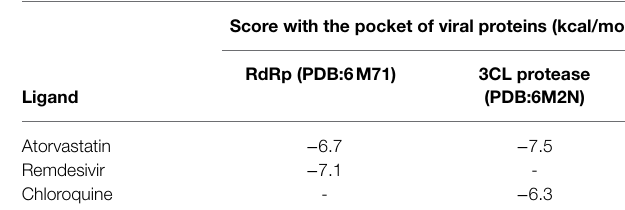
TABLE 3 | Molecular docking of atorvastatin and positive controls of interaction (Remdesivir and Chloroquine) with two SARS-CoV-2 proteins. Score with the pocket of viral proteins (kcal/mol)